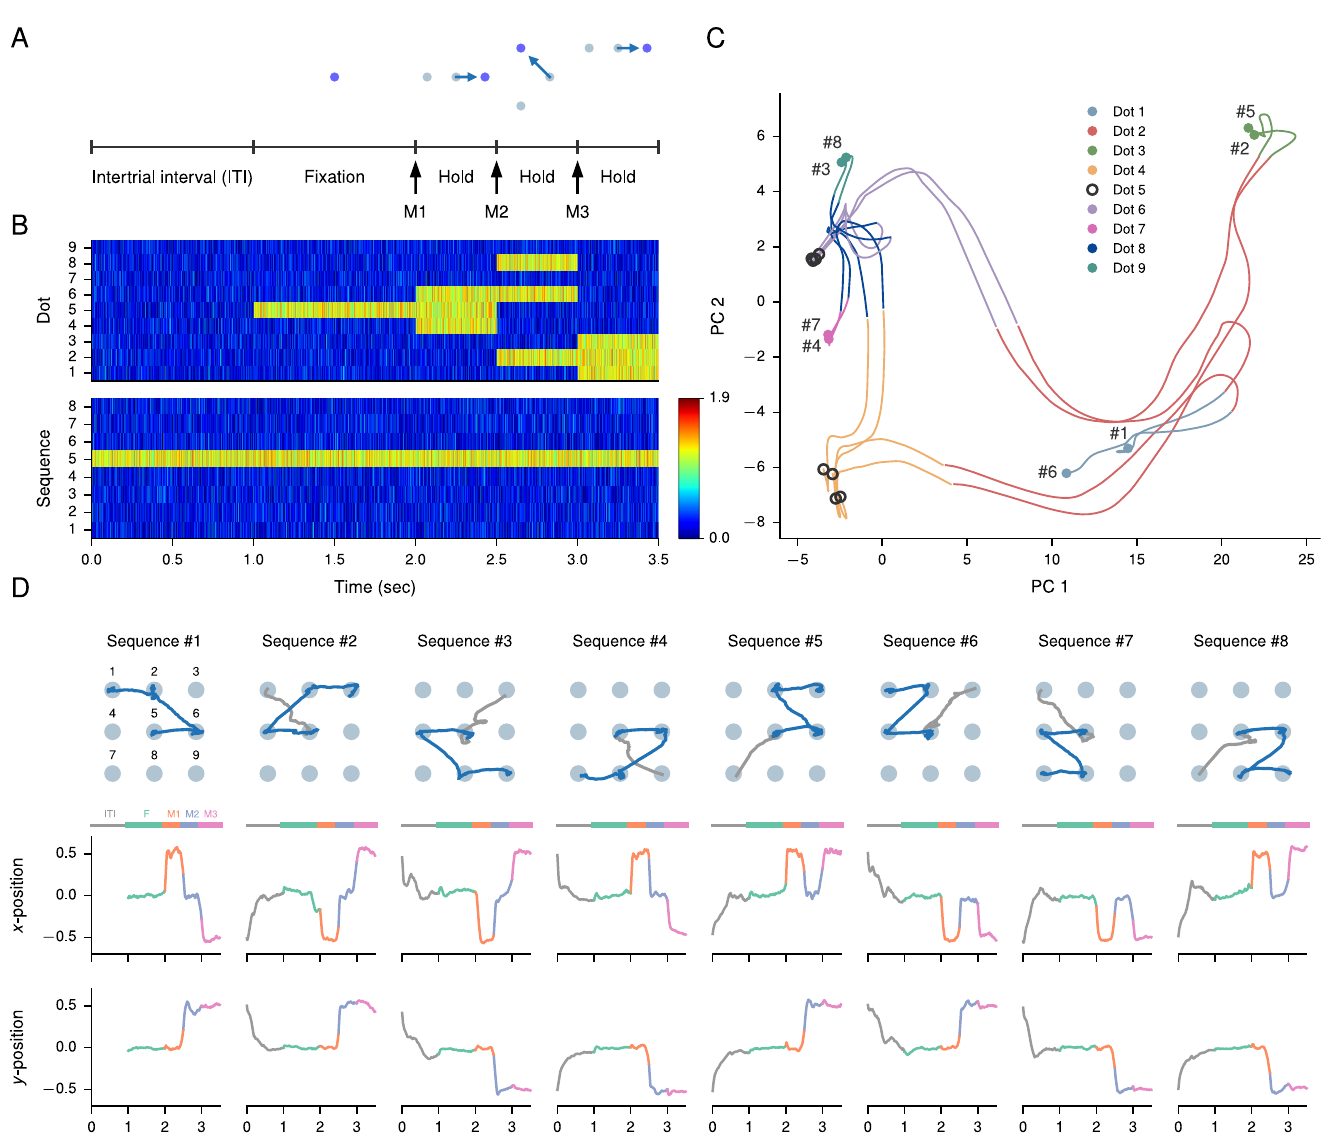
Fig 8. Eye-movement sequence execution task. (A) Task structure (for Sequence 5) and (B) sample inputs to the network. During the intertrial interval (ITI) the network receives only the input indicating the current sequence to be executed. Fixation is indicated by the presence of a fixation input, which is (the central) one of 9 possible dot positions on the screen. During each movement, the current dot plus two possible target dots appear. (C) State-space trajectories during the three movements M1, M2, and M3 for each sequence, projected on the first two principal components (PCs) (71% variance explained, note the different axis scales). The network was run with zero noise to obtain the plotted trajectories. The hierarchical organization of the sequence of movements is reflected in the splitting off of state-space trajectories. Note that all sequences start at fixation, or dot 5 (black), and are clustered here into two groups depending on the first move in the sequence. (D) Example run in which the network continuously executes each of the 8 sequences once in a particular order; the network can execute the sequences in any order. Each sequence is separated by a 1-second ITI during which the eye position returns from the final dot in the previous trial to the central fixation dot. Upper: Eye position in “ screen ” coordinates. Lower: x and y -positions of the network ’ s outputs indicating a point on the screen. Note the continuity of dynamics across trials. For this task we trained a 200-unit (160 excitatory, 40 inhibitory) network on a trial-by-trial basis, i.e., the network parameters were updated after each trial. This corresponds to setting the gradient minibatch size to 1. Moreover, the network was run “ continuously, ” without resetting the initial conditions for each trial (Fig 8D). During the intertrial interval (ITI), the network